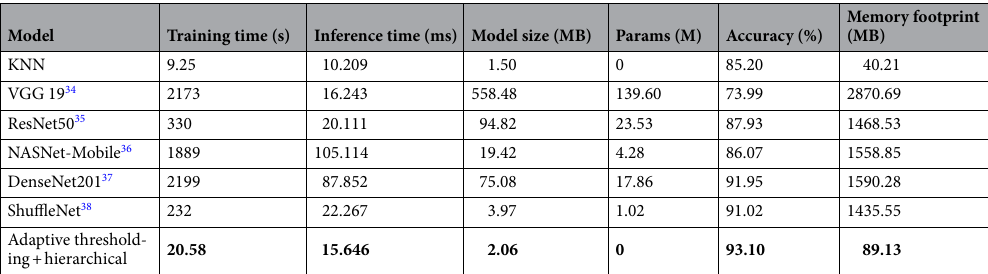
Table 13. Computational metrics and accuracy comparison of proposed adaptive thresholding method and alternative approaches.